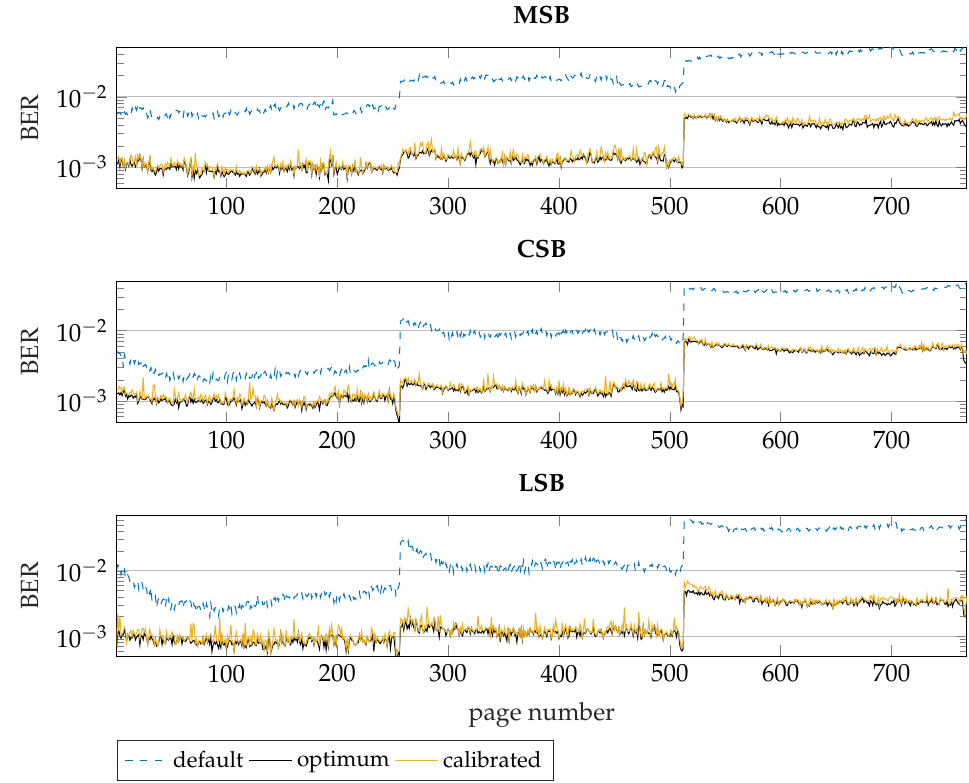
Figure 10. Residual BER of proposed calibration compared to minimum BER.